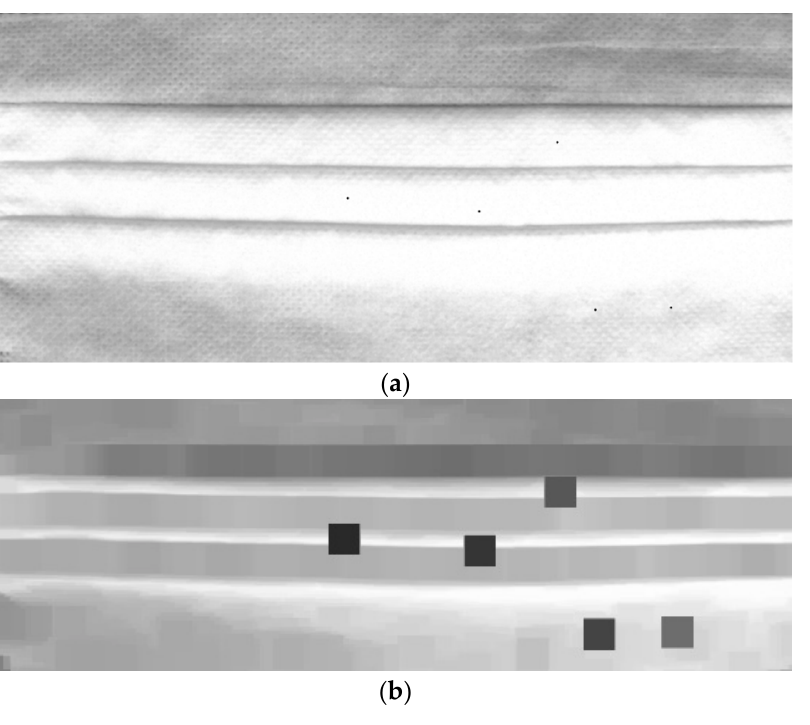
Figure 8. Apply various template matching methods in the mask image, ( a ) apply the minimum cross coefficient method; ( b ) apply the minimum cross correlation method; and ( c ) apply the minimum square difference method.